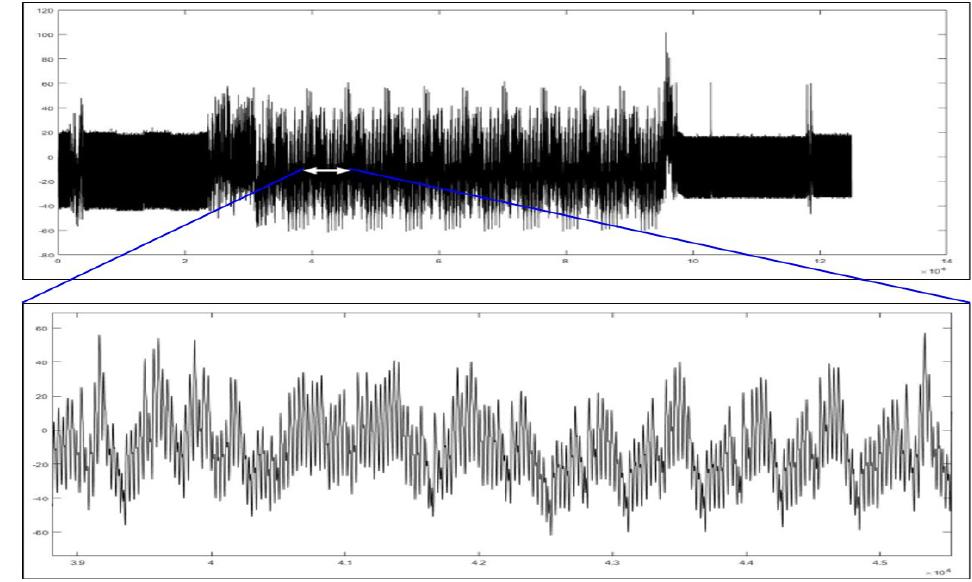
Figure 2. Part of a single execution of the